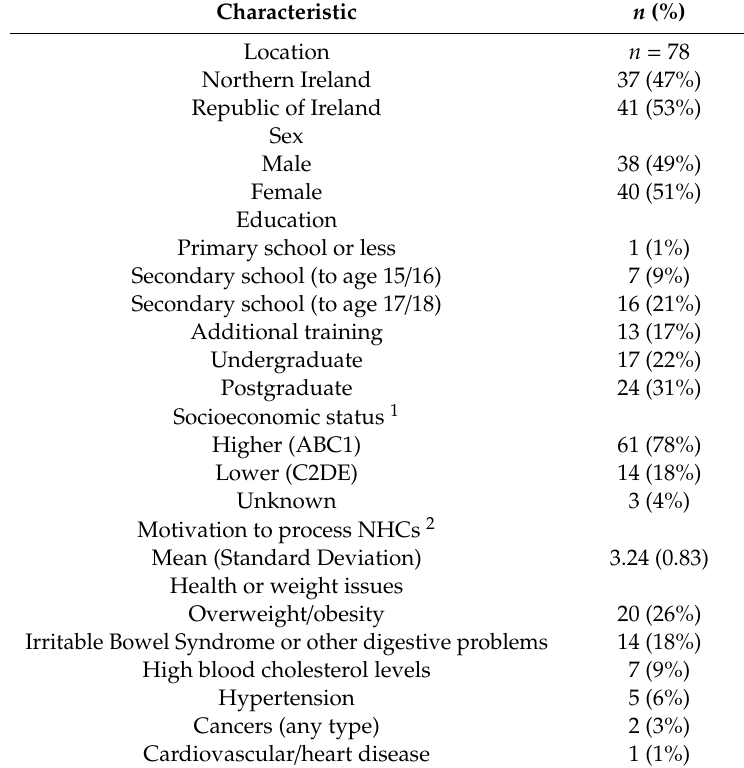
Table 1. Characteristics of focus group participants ( n =